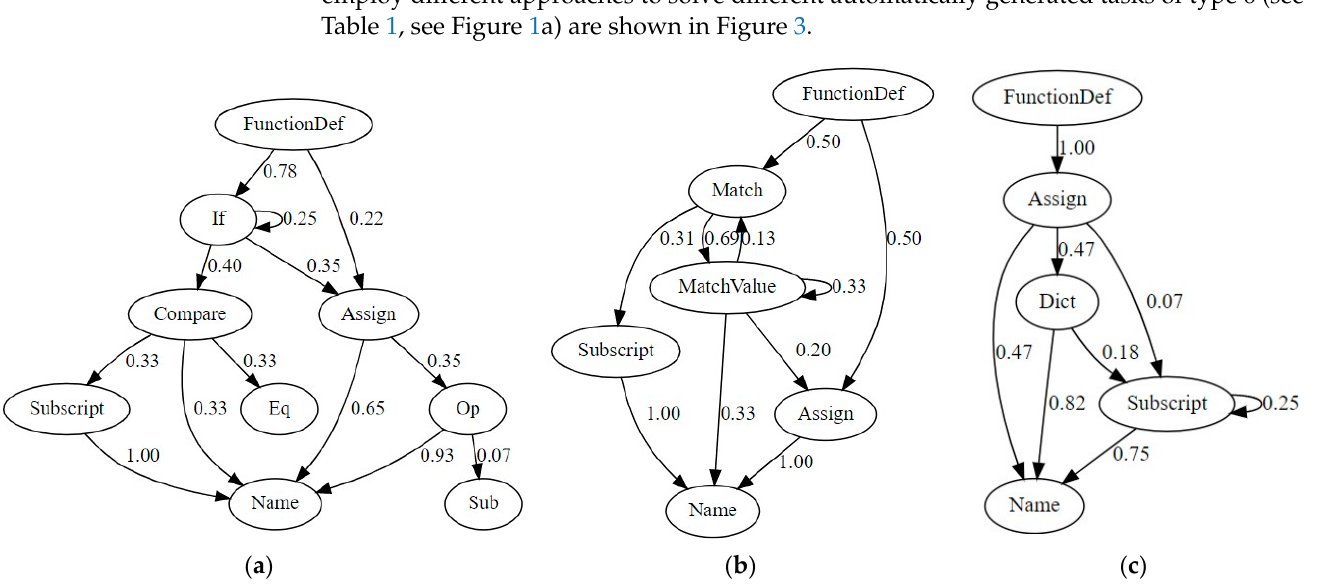
Figure 3. Markov chain state transition graphs for programs that employ different approaches to solve automatically generated tasks of type 6 (see Table 1, see Figure 1a): ( a ) solution using condi-